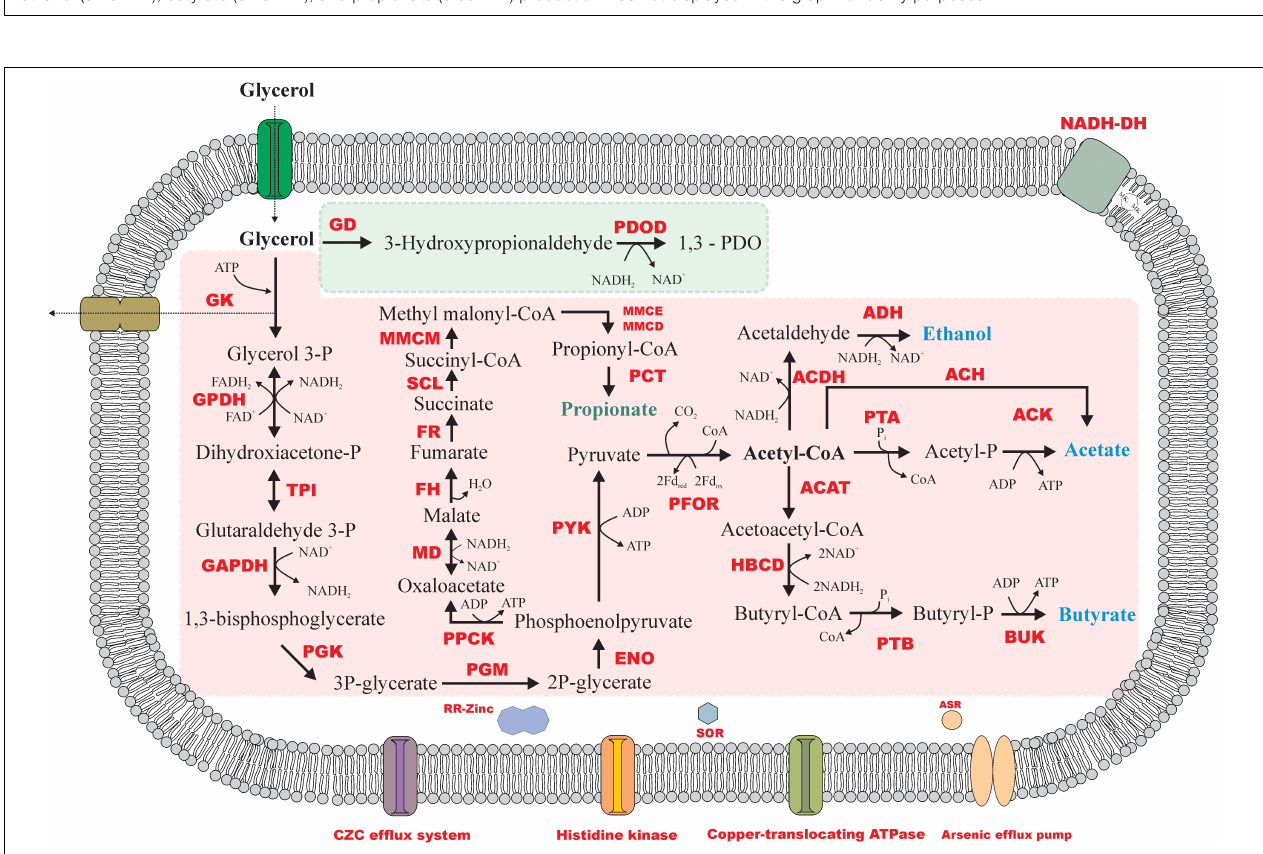
FIGURE 5 | Metabolic reconstruction of glycerol fermentation by strain ALE T . Reductive and oxidative routes of glycerol degradation are represented by the green and the pink area, respectively. GD, glycerol dehydratase; PDOD, 1,3-PDO dehydrogenase; GK, glycerol kinase; GPDH, glycerol-3P dehydrogenase; TPI, triose phosphate isomerase; GAPDH, glyceraldehyde-3P dehydrogenase; PGK, phosphoglycerate kinase; PGM, phosphoglycerate mutase; ENO, enolase; PYK, pyruvate kinase; PFOR, pyruvate:ferredoxin oxidoreductase; PTA, phosphotransacetylase; ACK, acetate kinase; ACAT, acetyl-CoA acetyltransferase; HBCD, hydroxybutyryl dehydrogenase; PTB, phosphotransbutyrylase; BUK, butyrate kinase; ACDH, acetaldehyde dehydrogenase; AD, alcohol dehydrogenase; PPCK, phosphoenolpyruvate kinase; MD, malate dehydrogenase; FH, fumarate hydratase; FR, fumarate reductase; SCL, succinyl-CoA ligase; MMCM, methyl malonyl-CoA mutase; MMCE, methyl malonyl-CoA epimerase; MMCD, methyl malonyl-CoA dehydrogenase; PCT, propionyl-CoA transferase; RR-Zinc, response regulator of zinc; SOR, superoxide reductase; ASR, arsenate reductase. Propionate was only found in the pH controlled chemostat experiment.